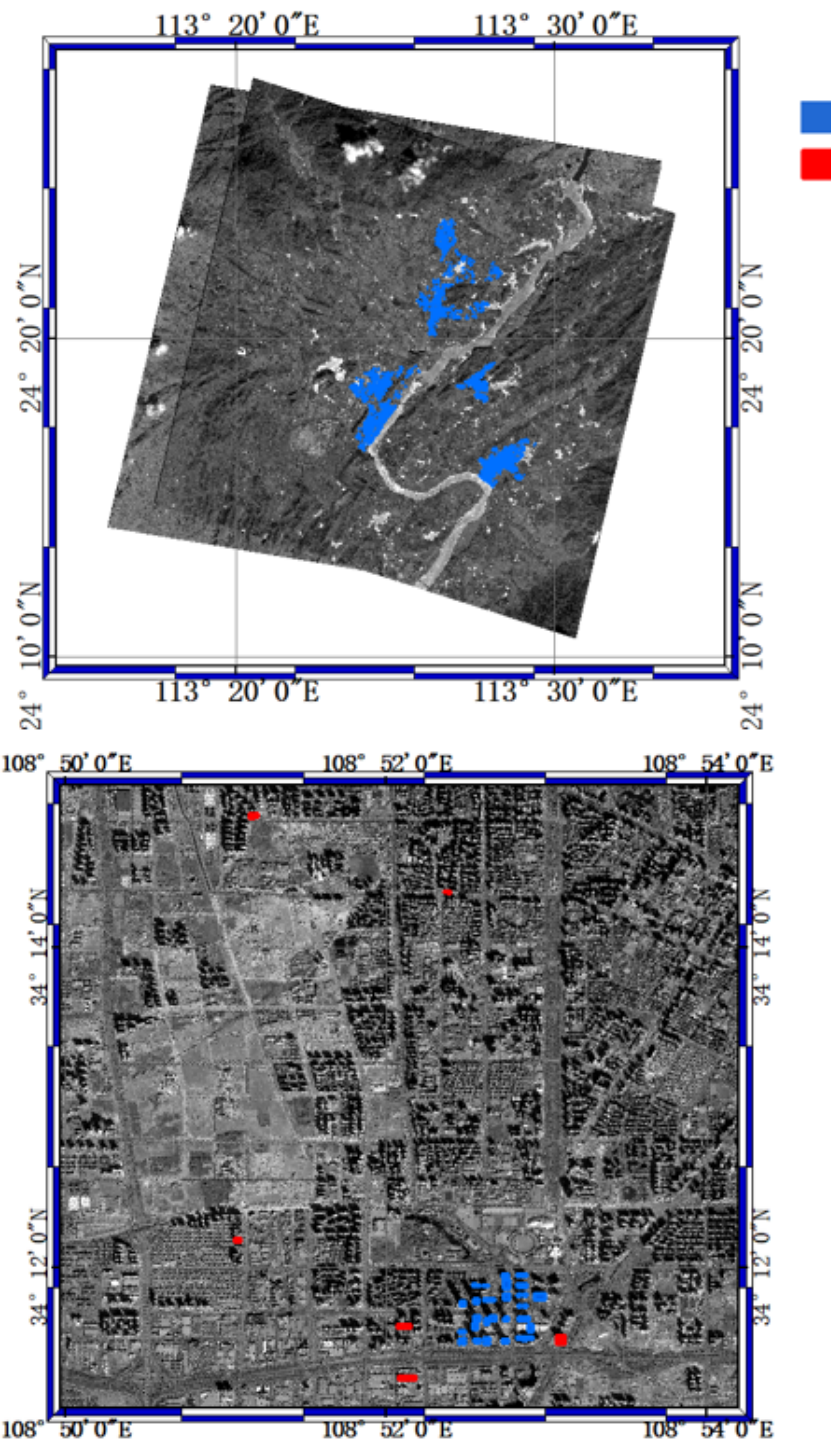
Figure 12. GF-7 images and building samples of the study